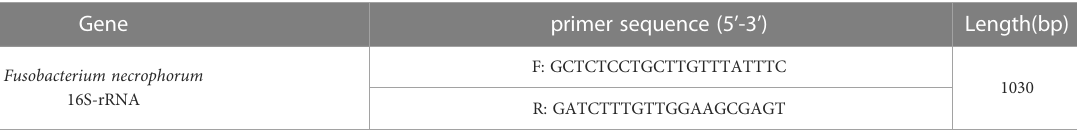
TABLE 1 Primer sequence of the